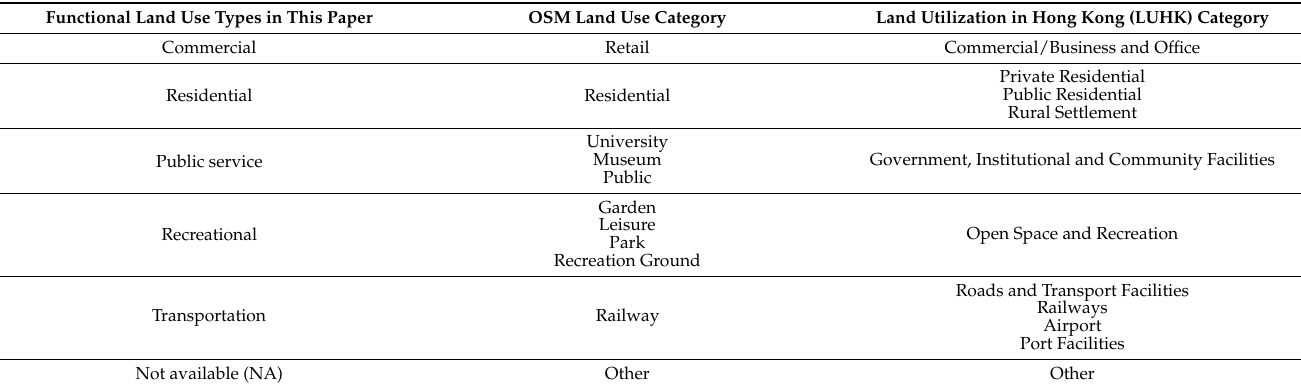
Table 1. Functional land use types in this study associated with OSM functional land use dataset and the Land Utilization in Hong Kong (LUHK)